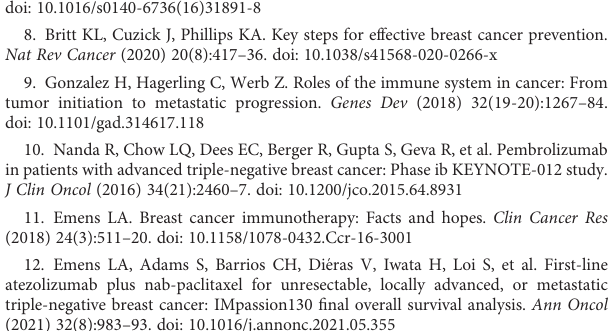
SUPPLEMENTARY FIGURE 2 Single-sample gene set enrichment analysis identi fi ed the relative in fi ltration of 28 types of immune cell subpopulations in different risk groups. SUPPLEMENTARY TABLE 1 A total of 42 NAM metabolism-related genes used in this study. SUPPLEMENTARY TABLE 2 The upregulated and downregulated NAM metabolism-related